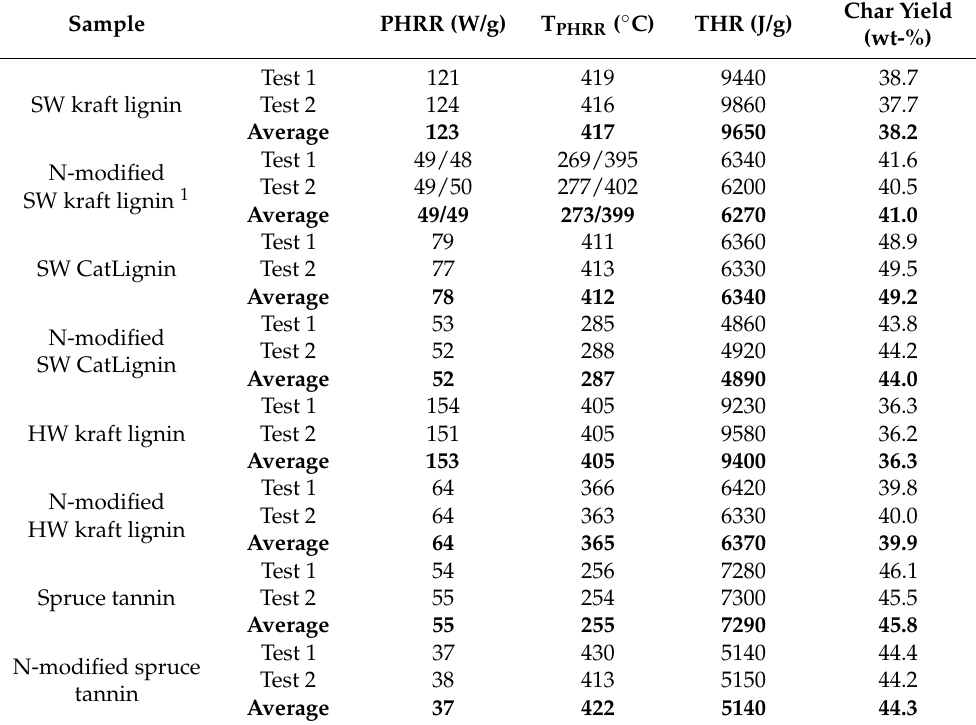
Table 2. MCC test results of pure